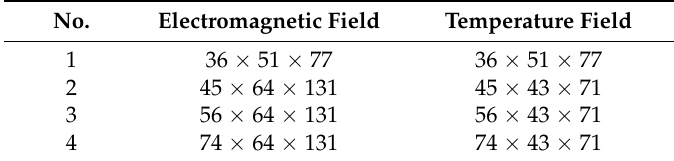
Table 3. Mesh number for electromagnetic and temperature field ( N θ × Nr × Nz